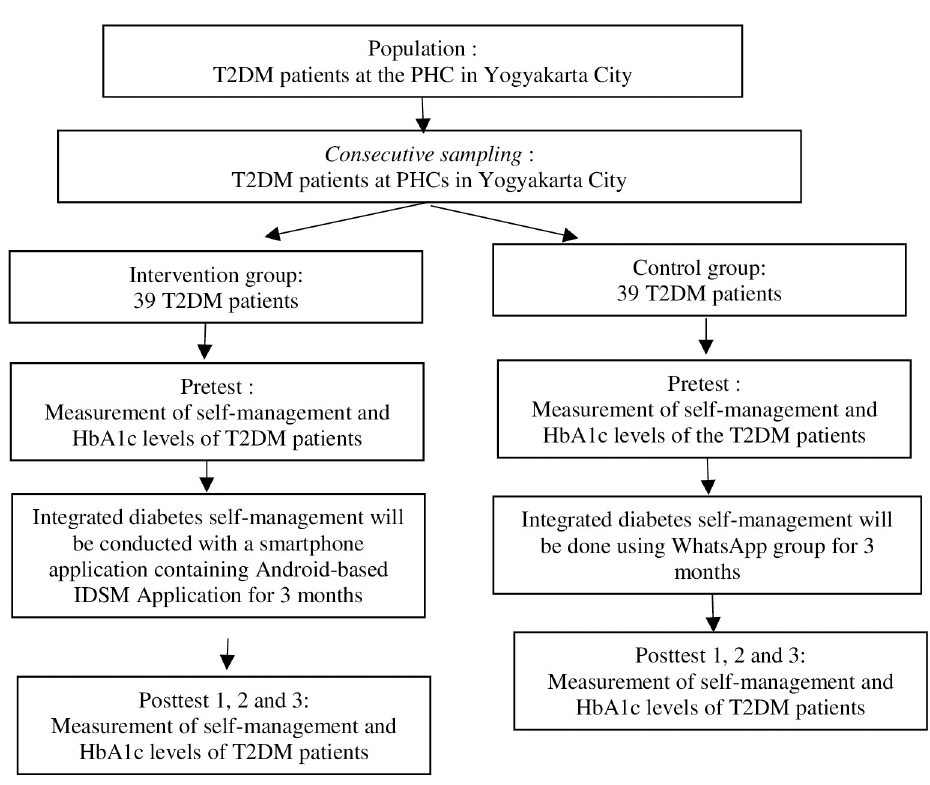
Fig 2. The quasi-experiment data collection